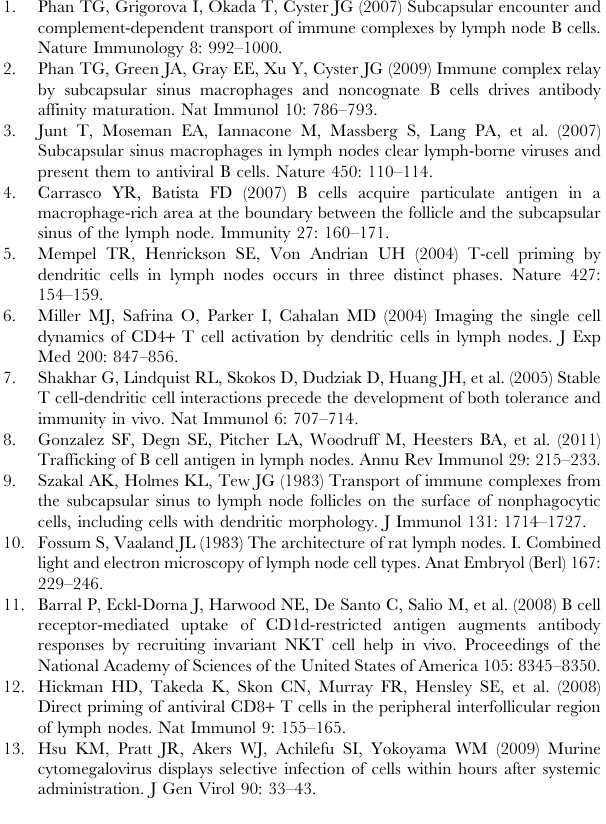
Figure S2 CD169 staining on Siglec1 –/– (CD169-defi- cient) IL-7R a hi CCR6 + lymphocytes and CD11c hi dendrit- ic cells in mixed bone marrow chimeras. Flow cytometric detection of CD169 staining on CD45.2 + Siglec1 –/– or Siglec1 + / + (red) compared to CD45.1 + Siglec1 + / + (blue) IL-7R a hi CCR6 + cells (A) and CD11c hi cells (B) in mixed bone marrow chimeric mice. Data are representative of two experiments. Figure S3 IL-7R a hi CXCR6 hi lymphocytes at the subcap- sular sinus and interfollicular regions. Immunofluores- cence microscopy of lymph node sections from Cxcr6 GFP/ + mice stained with anti-CD169 (blue) and anti-IL-7R a (red) monoclonal antibodies. Two examples are shown and are representative of sections from four lymph nodes from two mice. FO, follicle; T, T zone. Scale bar = 50 m